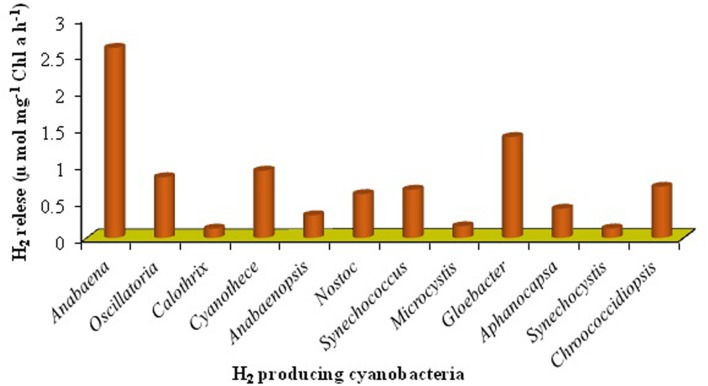
Production of H2 from cyanobacteria (data has been modified from Dutta et al., 2005).